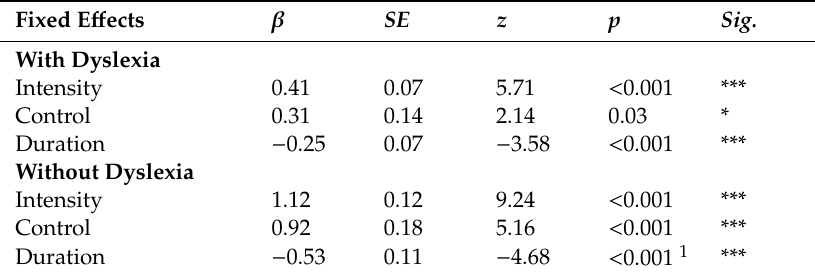
Table A3. Results of two generalized mixed e ff ects models (one for the group of adults with dyslexia, and one for the group of adults without dyslexia) to test the groups’ preferences against chance in the three acoustic conditions reported in Section 3.3.